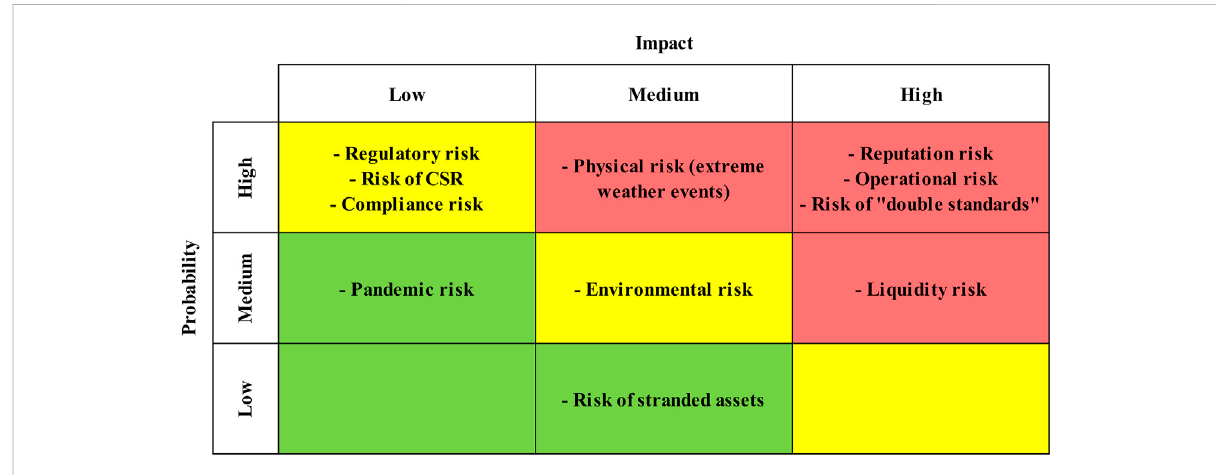
Risk map for German-Japanese banking system, Source: own elaboration.